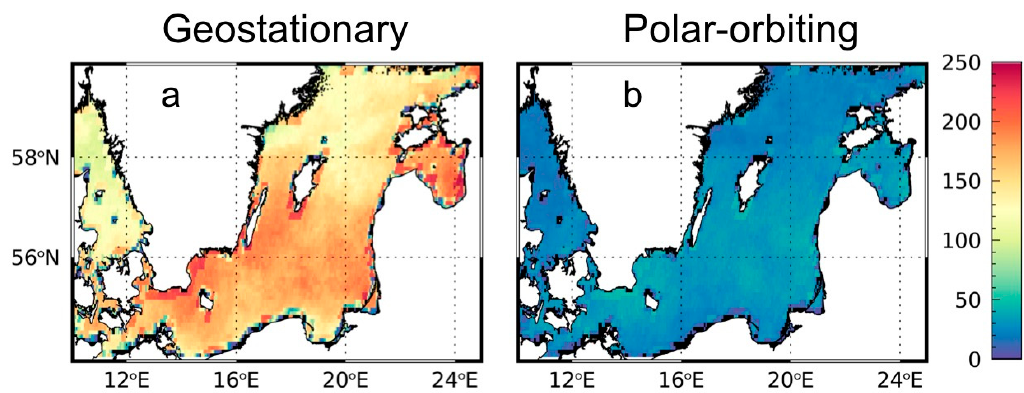
Figure 5. Number of valid observations in case of GEO ( a ) and LEO ( b ) in May 2016. Observations with solar zenith angles greater than 70° were excluded.